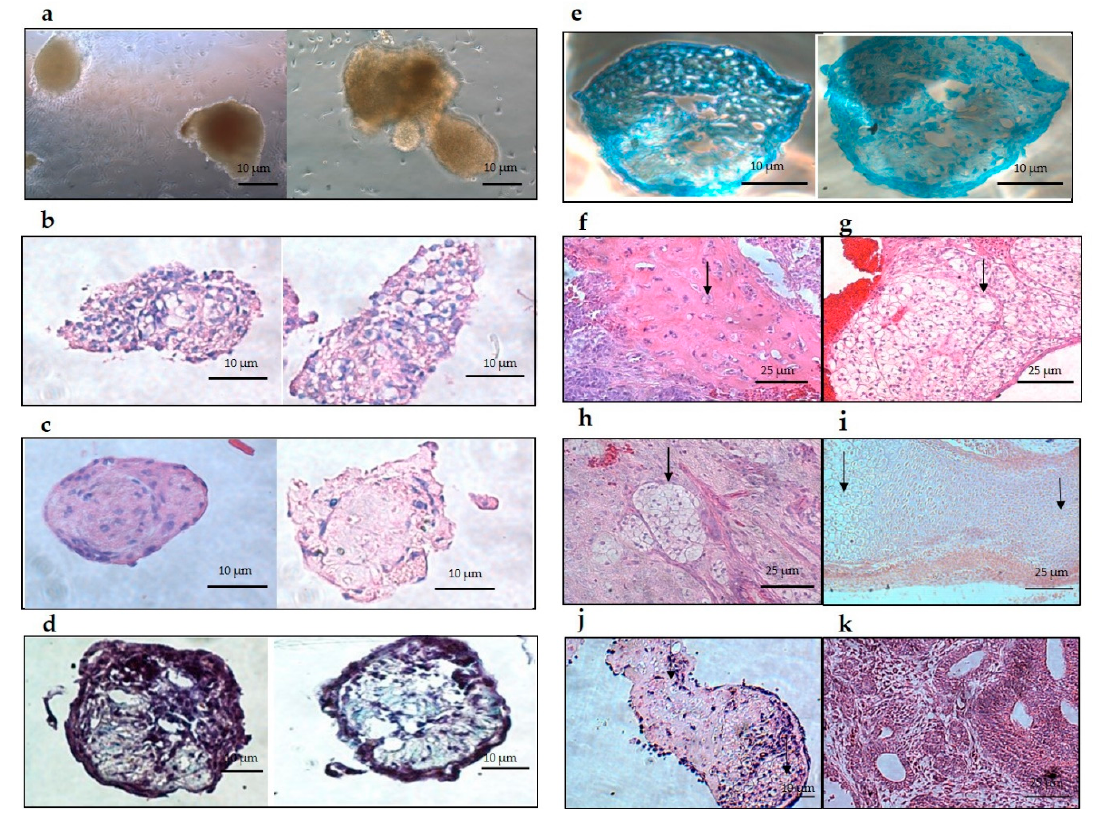
Figure 6. Cartilage structure and glycosaminoglycan (GAG) are present in the transdifferentiated aggregates. ( a ) Compact cartilage aggregates in culture. ( b ) Cartilage-like tissue stained by H & E. ( c ) Hyaline cartilage-like tissue stained by H & E with sparse chondroblasts in the lacunae structure (Scale bar 10 μ m). ( d ) (GAG) deposition stained by Safranin-O. ( e ) (GAG) deposition stained by Alcian blue. ( f ) H & E staining of hyaline chondroblasts and hyaline matrix found in vivo following transplantation in mice. ( g , h ) H & E staining of hypertrophic chondroblasts in a subcutaneous capsule. ( i ) H & E staining of developing limb bud in a mouse embryo showing natural, normal hyaline (right arrow) and hypertrophic (left arrow) chondroblasts (Scale bar 25 μ m). ( j ) H & E staining of chondroblast aggregates differentiated from mouse iPSCs showing hyaline cartilage-like tissue with chondroblasts in lacunae (left arrow) and hypertrophic chondroblasts (right arrow) (Scale bar 10 μ m). ( k ) IPSCs derived teratoma showing heterogenous tissue formation (Scale bar 25 μ m).